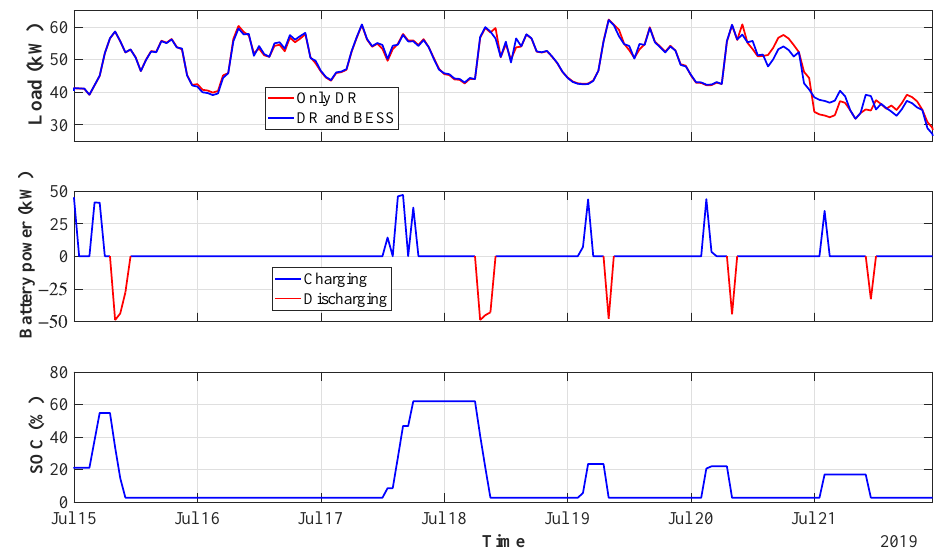
Figure 13. DR and BESS in summer.